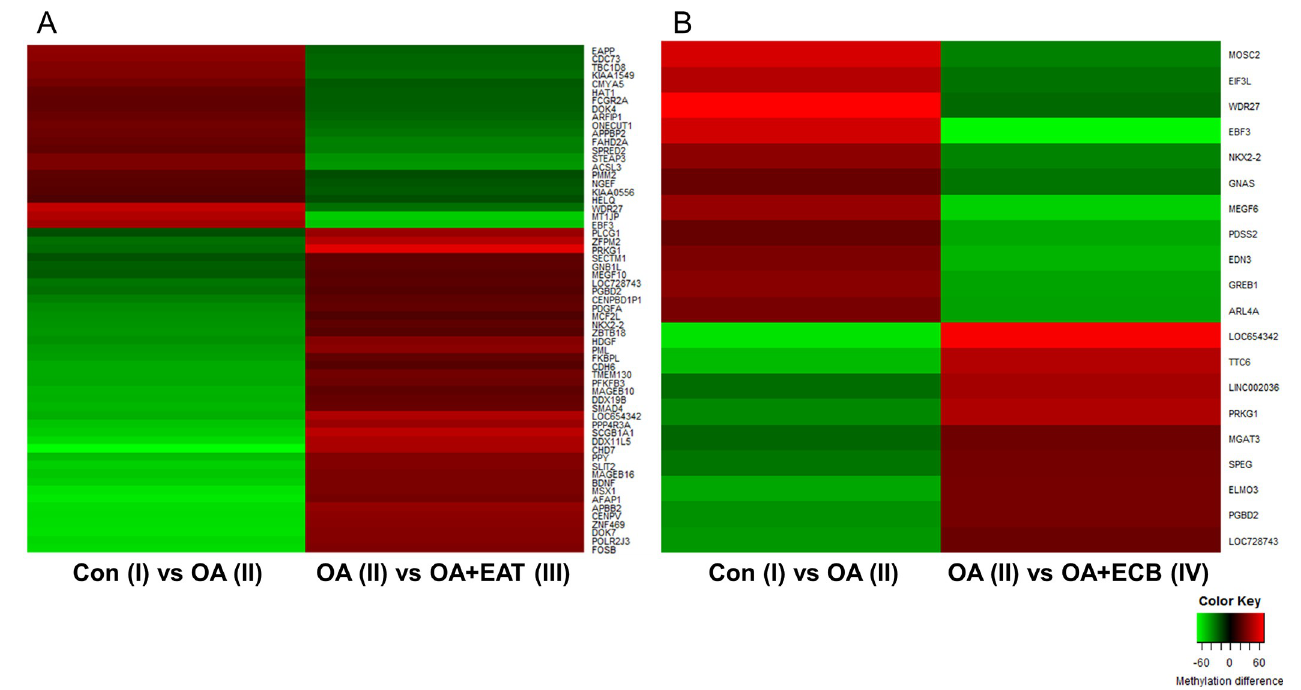
Fig 3. Heatmap of selected DMRs. (A) Heatmap of methylation levels of the 61 DMRs in the control (I) vs OA (II) and OA (II) vs OA+EAT (III) comparisons. (B) 20 DMRs in the control (I) vs OA (II) and OA (II) vs OA+ECB (IV) comparisons ( p < 0.01, methylation difference between groups > 20%).